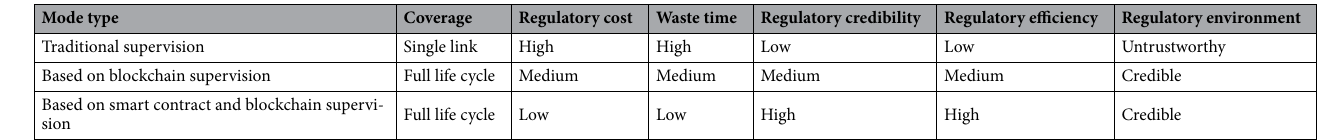
Table 4. Comparison of rice supervision